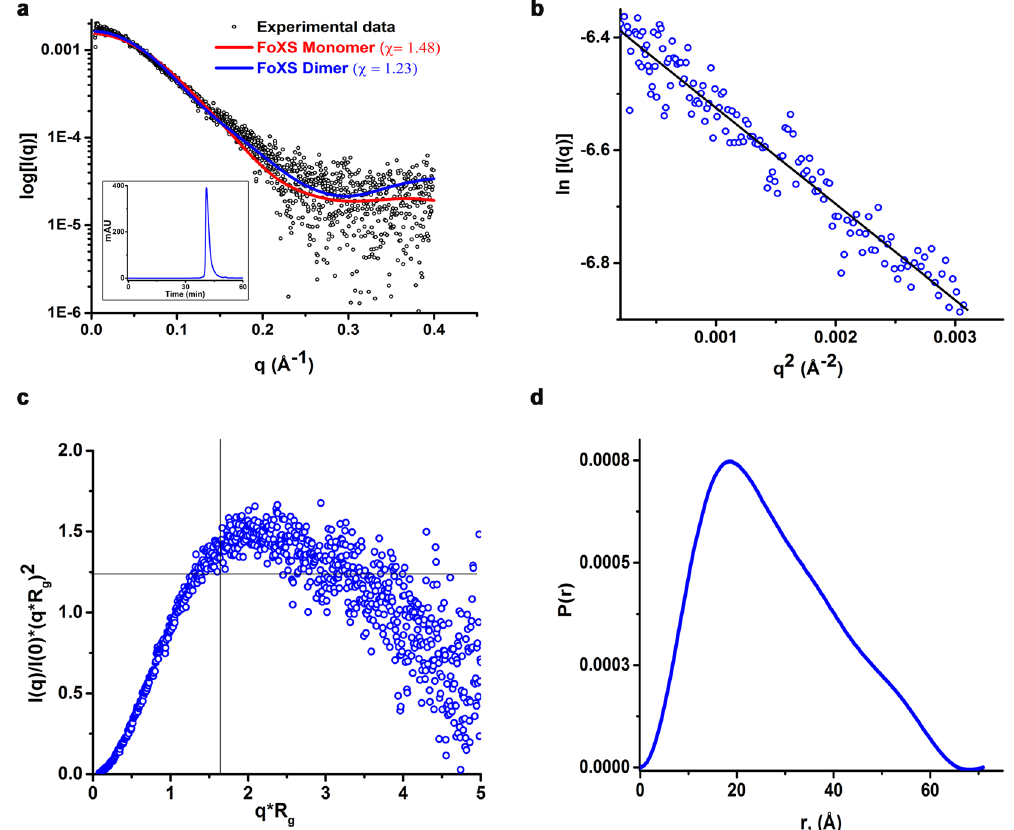
Figure 2. The SEC-SAXS analysis of CarD. ( a ) Scattering data obtained for CarD at 277 μ M concentration. Inset shows the in-line SEC-trace of the CarD. CarD elutes as a single peak with no apparent signs of aggregation. FoXS web server analysis reveals that the theoretically calculated scattering profile from domain- swapped dimeric crystal structure (blue) matches well ( χ = 1.23) with the experimentally observed scattering profile (black) whereas the monomeric CarD (red) shows relatively poor fit ( χ = 1.48). ( b ) The linear low-q region (0.04–0.18) of the scattering curves were used for the Guinier analysis. ( c ) Kratky analysis of the CarD suggests CarD is well folded and flexible in solution. ( d ) Normalized pair distance distribution [P(r)] function suggests D max of around 72 Å for